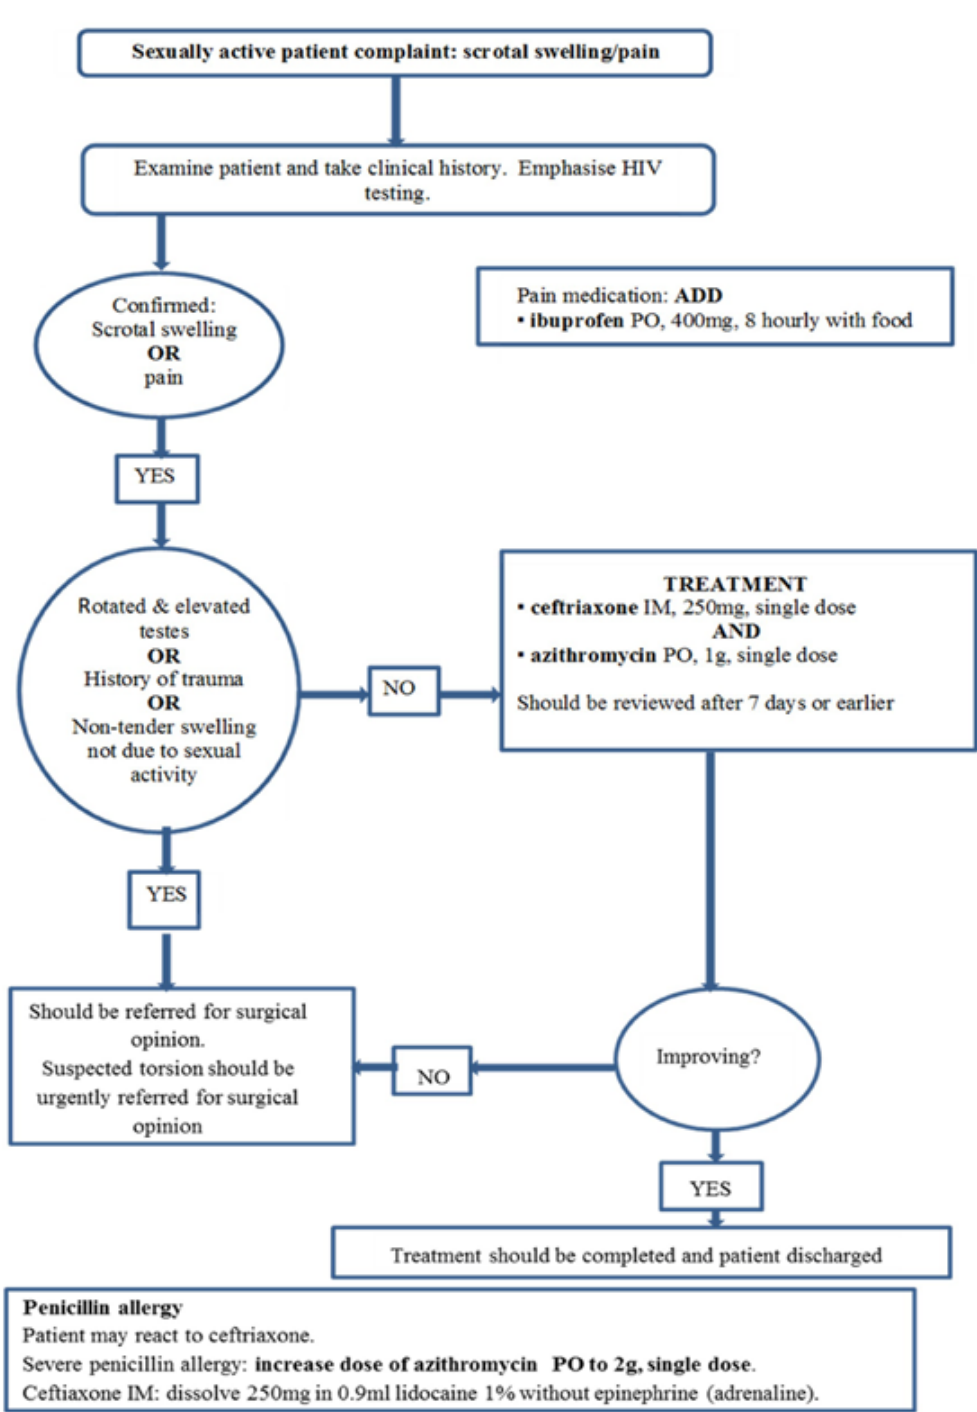
Figure 4: Flowchart of syndromic treatment of Scrotal Swelling. (adapted from the revised SSW flowchart of the Primary Health Care Standard Treatment Guidelines and Essential Drugs List, 2015)